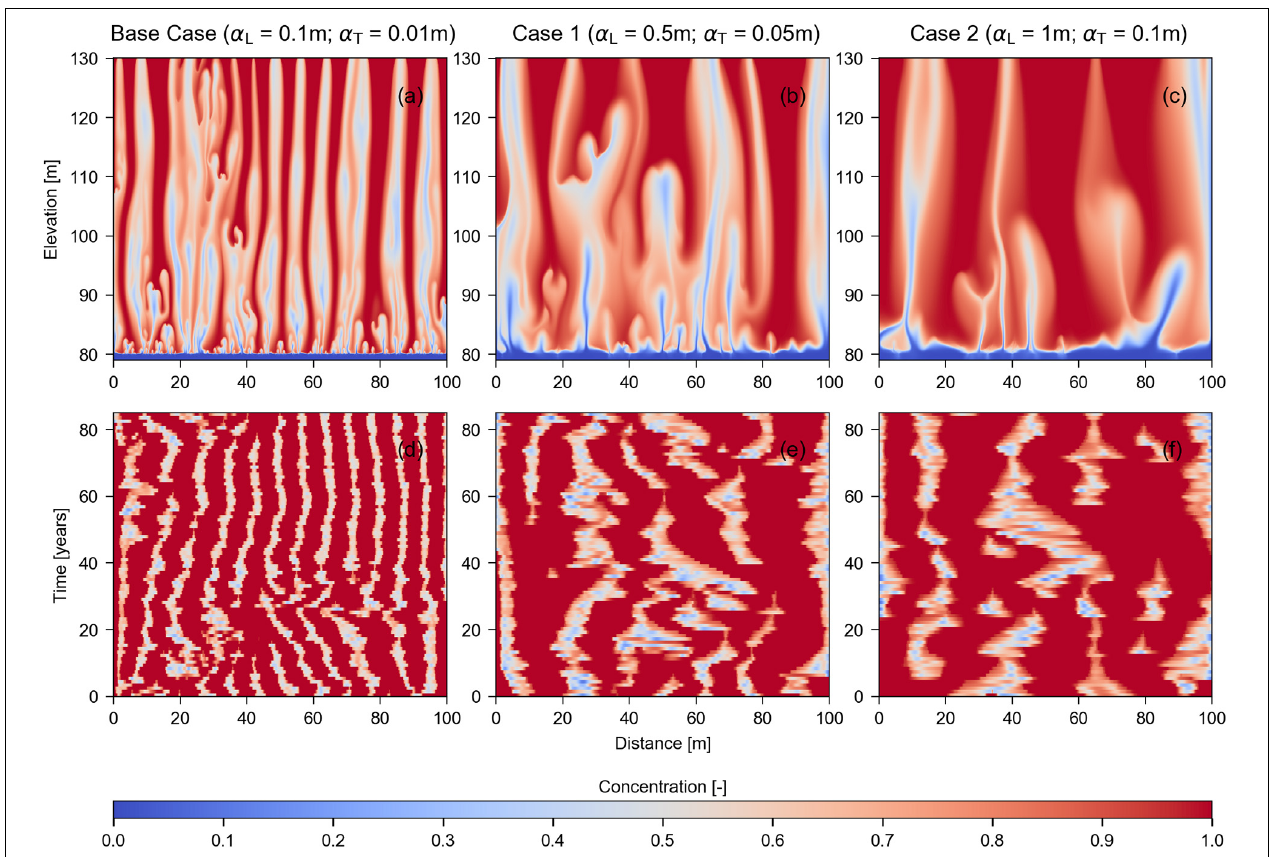
FIGURE 7 | Salinity distribution in profile [subplots (a–c) ; top row] and temporal variation of solute concentration [subplots (d–f) ; bottom row] in seafloor sediments obtained from Model B simulations: Subplots are (from left to right) the Base Case, Case 1, and Case 2. Concentration values represent the relative seawater concentration, where 0 and 1 are freshwater and seawater, respectively. All subplots show a quasi-steady state salinity